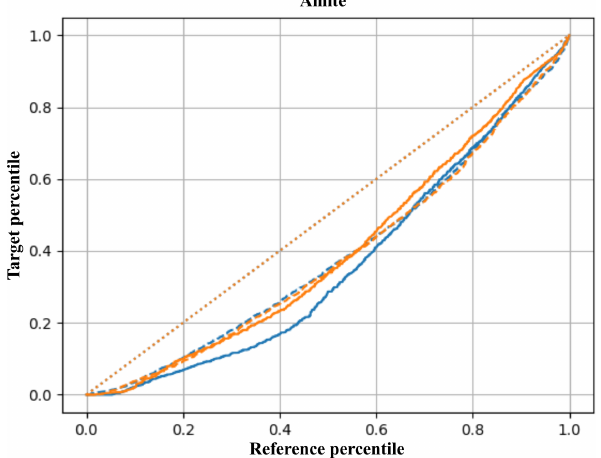
Figure 5. The transformation functions of the 1951–1960 FDC (solid) and API (dashed) to the target periods 1971–1980 (blue) and 1981–1990 (orange) for Bogue. For the sake of comparison, the di- agonal is dotted in